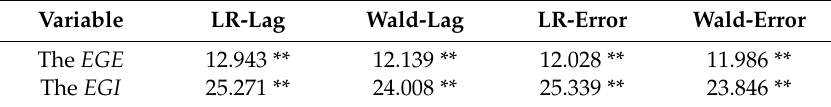
Table 3. Test results of the Wald test and LR test for the EGE and EGI